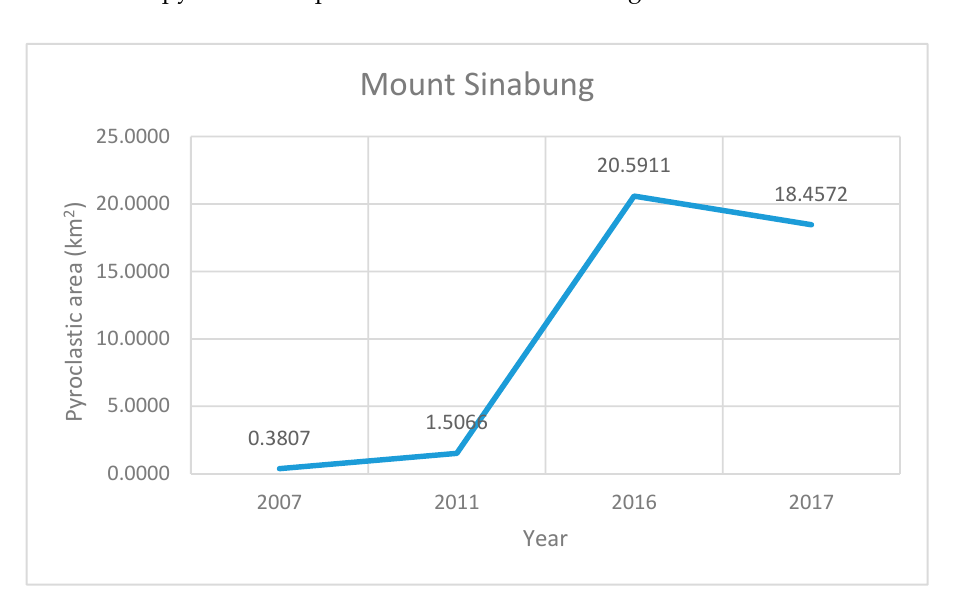
Figure 7. Time series of pyroclastic flow deposits for Mount Sinabung. Table 1. Time series of pyroclastic flow deposits.